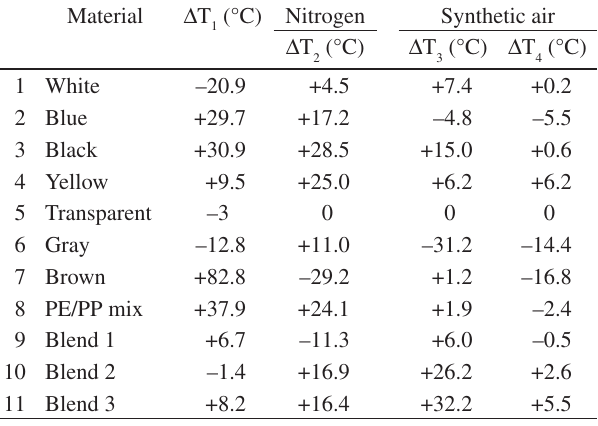
Table 2. Temperature differences: ∆ T material – T material; ∆ T